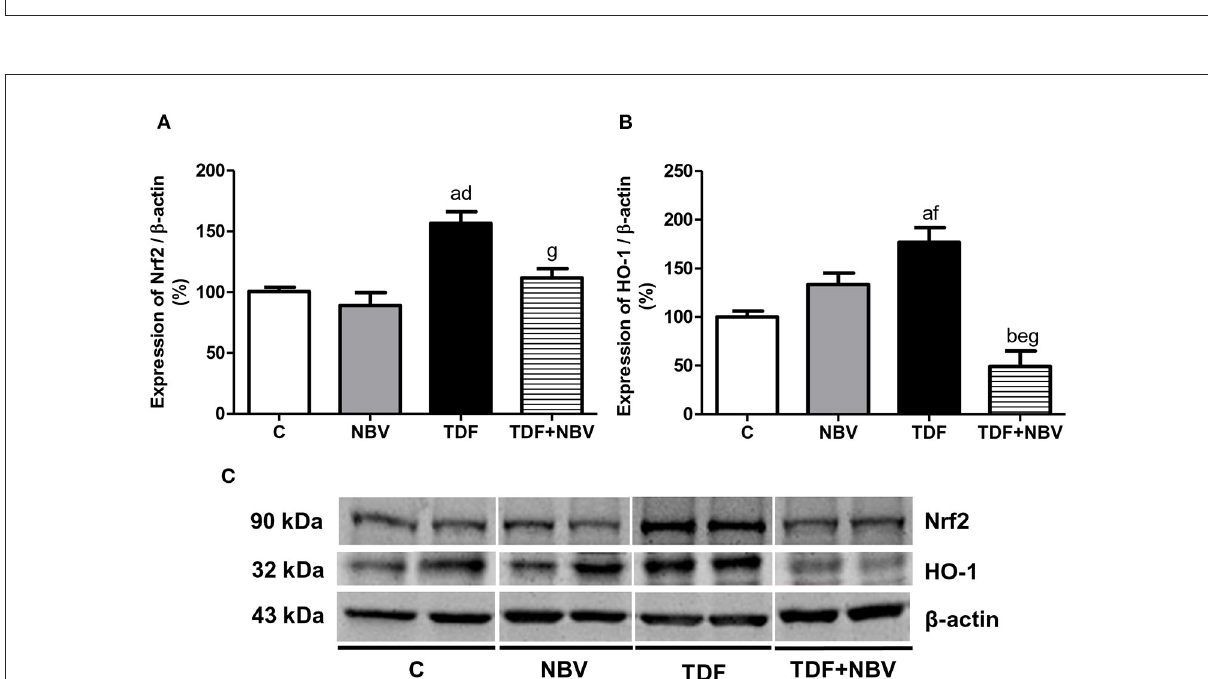
FIGURE8 Semiquantitative immunoblotting for Nrf2 and HO-1 expression in rat kidney tissue. (A) Nrf2 densitometric analysis of samples from C ( n = 7), NBV ( n = 7), TDF ( n = 8) and TDF + NBV ( n = 8) rats. (B) HO-1 densitometric analysis of samples from C ( n = 7), NBV ( n = 7), TDF ( n = 8) and TDF + NBV ( n = 8) rats. (C) Representative immunoblots which reacted with anti-Nrf2 and anti-HO-1 revealing bands of 90 and 32kDa, respectively. Values are means ± SEM. a p < 0.001, b p < 0.01 vs. C; d p < 0.001, e p < 0.01, f p < 0.05 vs. NBV; g p < 0.001 vs. TDF. C, control; NBV, Nebivolol; TDF,